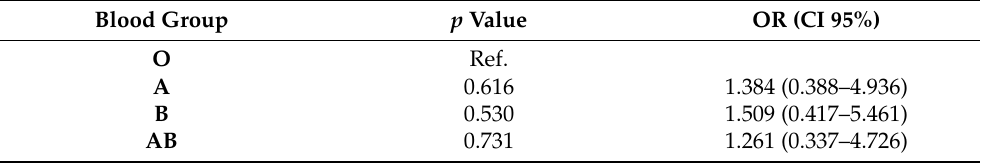
Table 2. Association between blood groups and positive SARS-CoV-2 test. Blood Group